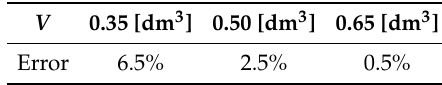
Table 3. Error parameter values for various volumes of the TPID